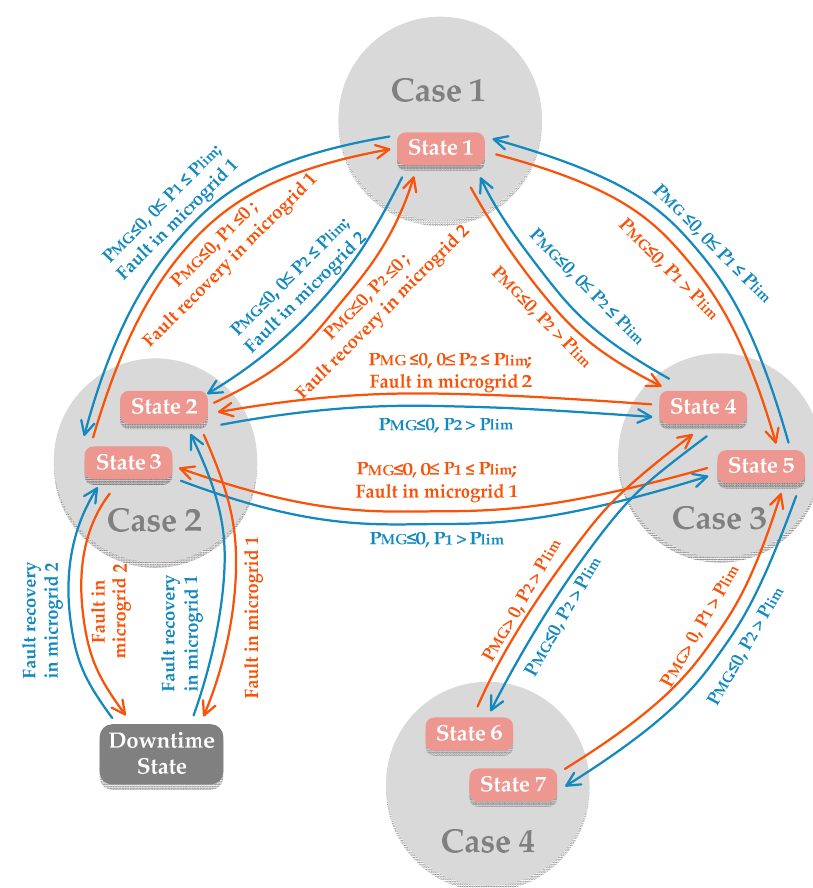
Figure 6. State-transition diagram of the energy router.